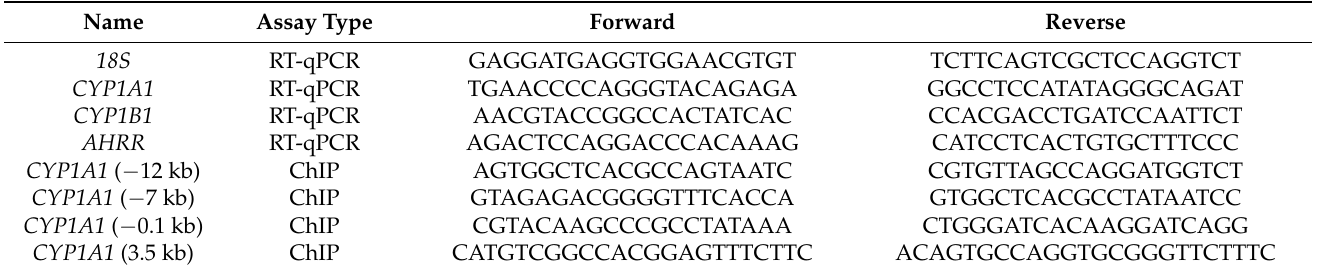
Table 1. Primer sequences for